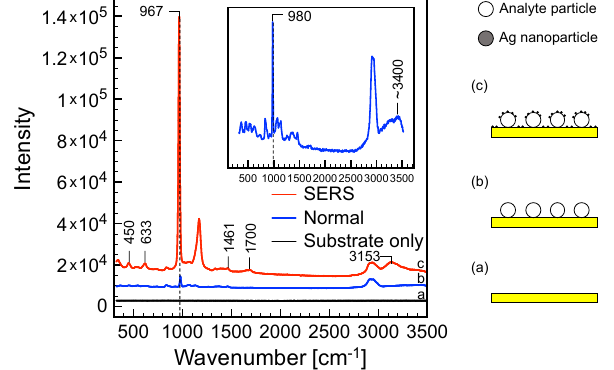
Figure 3. Normal Raman spectrum of substrate (black, a ) and the AS / sucrose particles (blue, b ) and SERS spectrum of the AS / sucrose particles (red, c ). The inset provides a magnified view of the normal Raman spectrum for comparison. The particle sizes are 23.3 and 43.7µm for normal Raman and SERS experiments, re- spectively. Schematics represent (a) substrate only, (b) analyte par- ticles on substrate and (c) analyte particles with Ag nanoparticles deposited on a substrate.